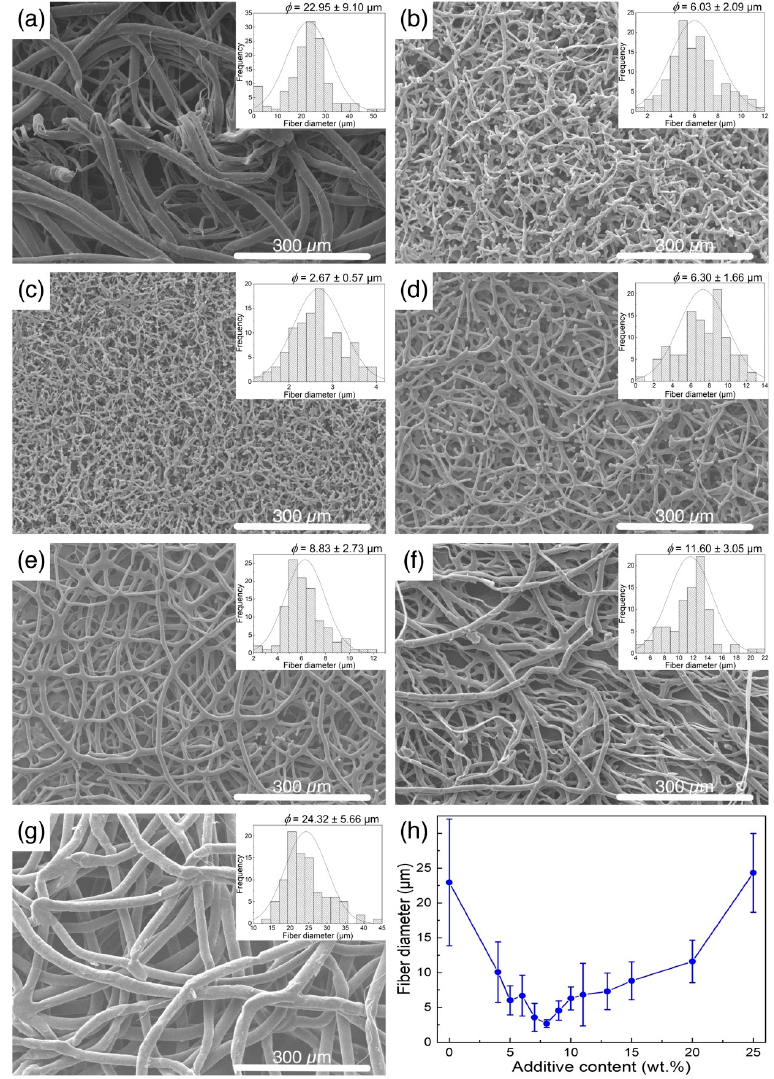
Figure 2. SEM images of the melt-electrospun Polycaprolactone (PCL) fibers: ( a ) without additive, ( b – g ) with an NaCl additive of ( b ) 5 wt %, ( c ) 8 wt %, ( d ) 10 wt %, ( e ) 15 wt %, ( f ) 20 wt %, and ( g ) 25 wt %. ( h ) Average diameter of the PCL fibers as a function of the additive